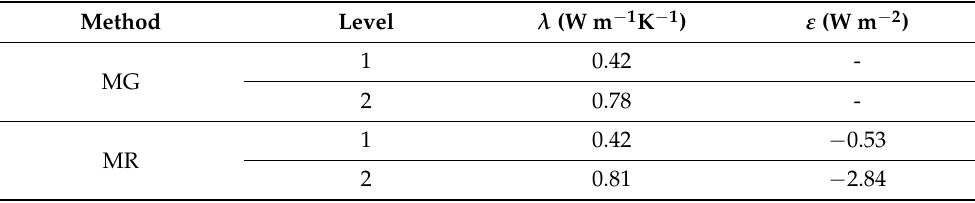
Figure 3. Daily soil thermal conductivity estimated by MG and MR models at levels 1 and 2. The annual λ value was the same in both methods for level 1 (Table 2), while for level 2, the MR presented values around 4% higher than the MG. The results for level 1 were almost 50% lower compared to level 2, for both methods, showing that λ varies with depth. In addition, the parameter ε estimated by MR showed a difference of approximately 5 times from one level to another (difference of 2.31 Wm − 2 ), being, in modulus, greater at the deepest level. Table 2. The annual value of λ obtained from different models and different soil levels and ε obtained from the MR model.